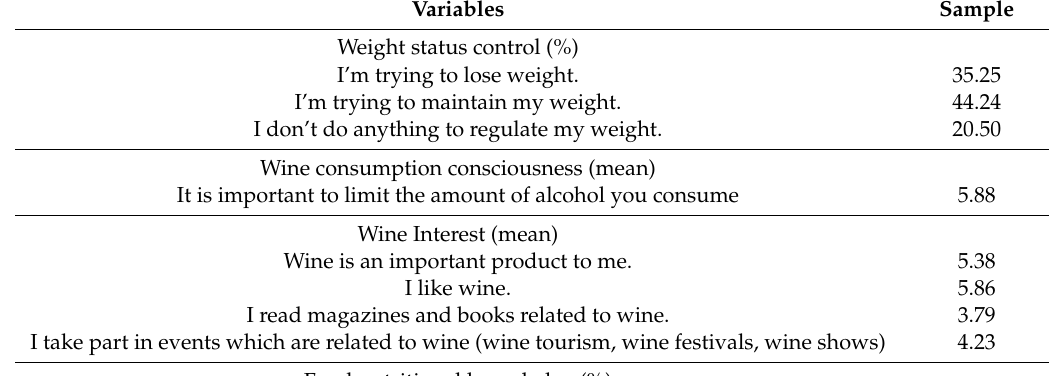
Table 3. Respondents’ attitudes and knowledge on health, food, and wine label use and wine drinking ( n =